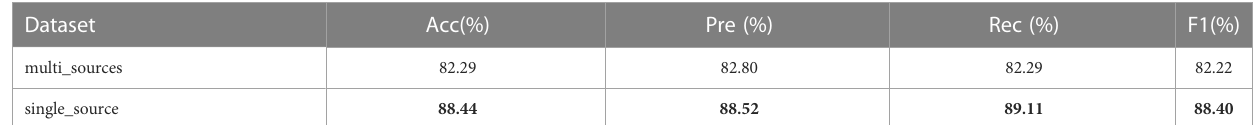
TABLE 5 Multi-source data